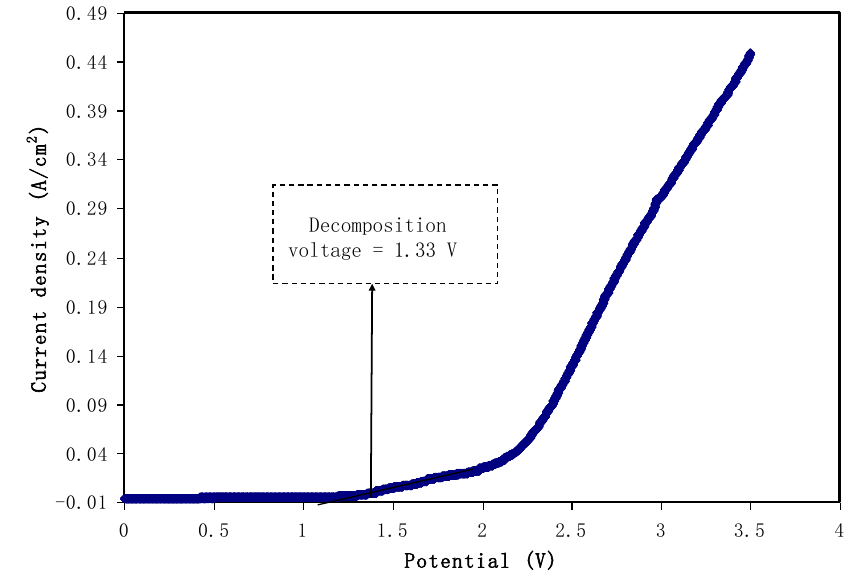
Figure 15. Linear sweep voltammetry (LSV) plot for the highest conducting (PVCS4) blend electrolyte film.